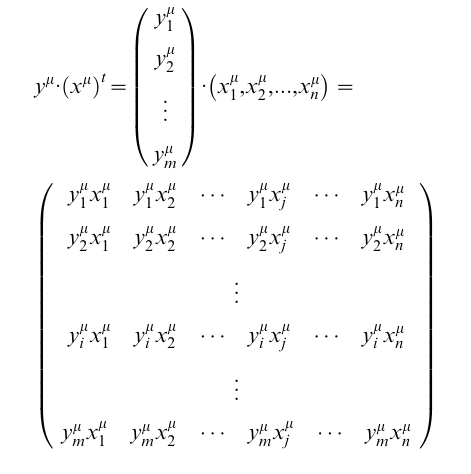
Table 2. Accuracy comparison with the original method (%) original